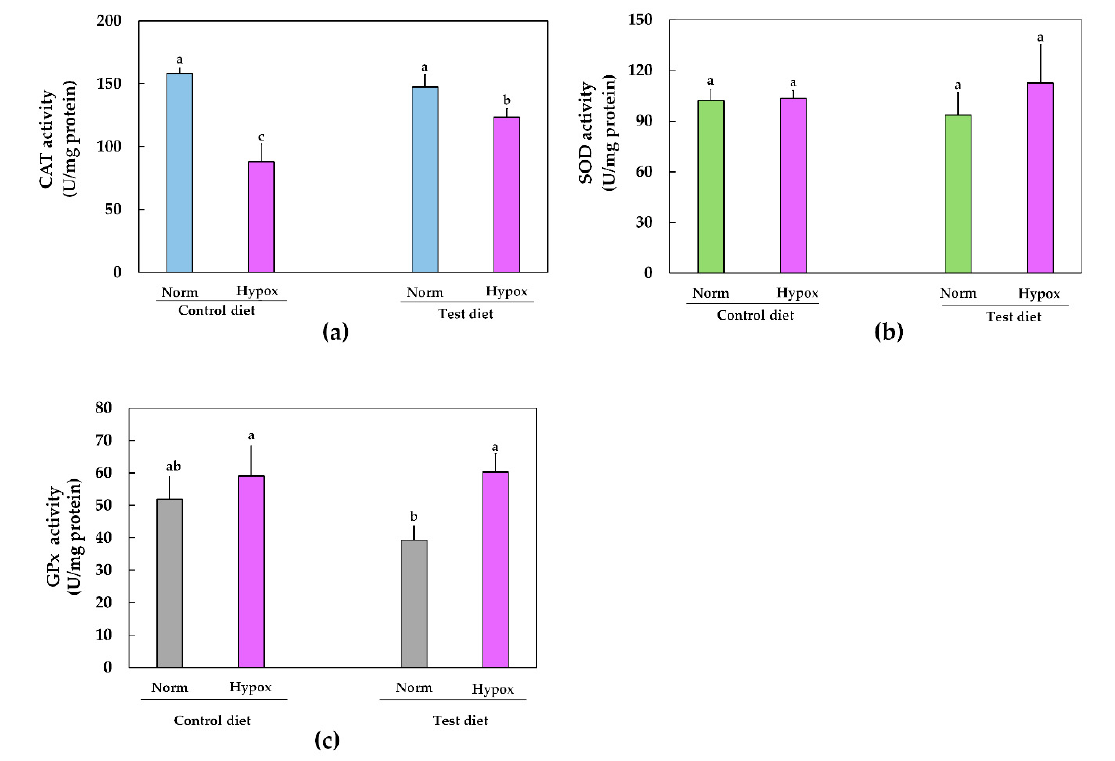
Figure 1. Effect of CHM (test diet) on hepatic ( a ) CAT, ( b ) SOD, and ( c ) GPx activities of Nile tilapia in normoxia (Norm) and exposed to 5 h of hypoxia (Hypox). Different letters indicate significant differences ( P < 0.05) among treatments using two-way analyses of variance (ANOVA) followed by Tukey’s post hoc.